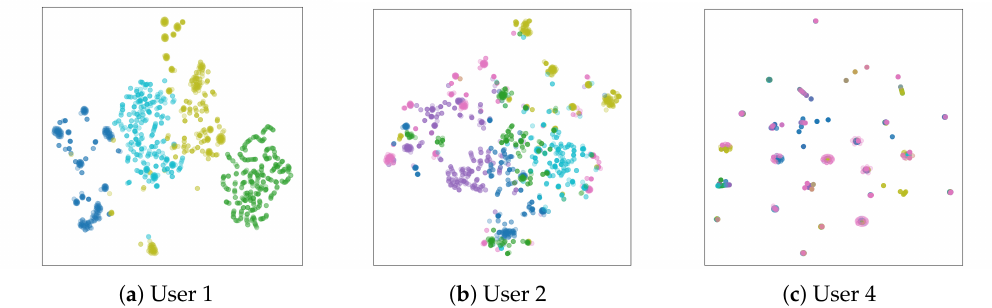
Figure 6. Training data of three after applying the T-SNE technique. Each color represents the samples belong to each room.